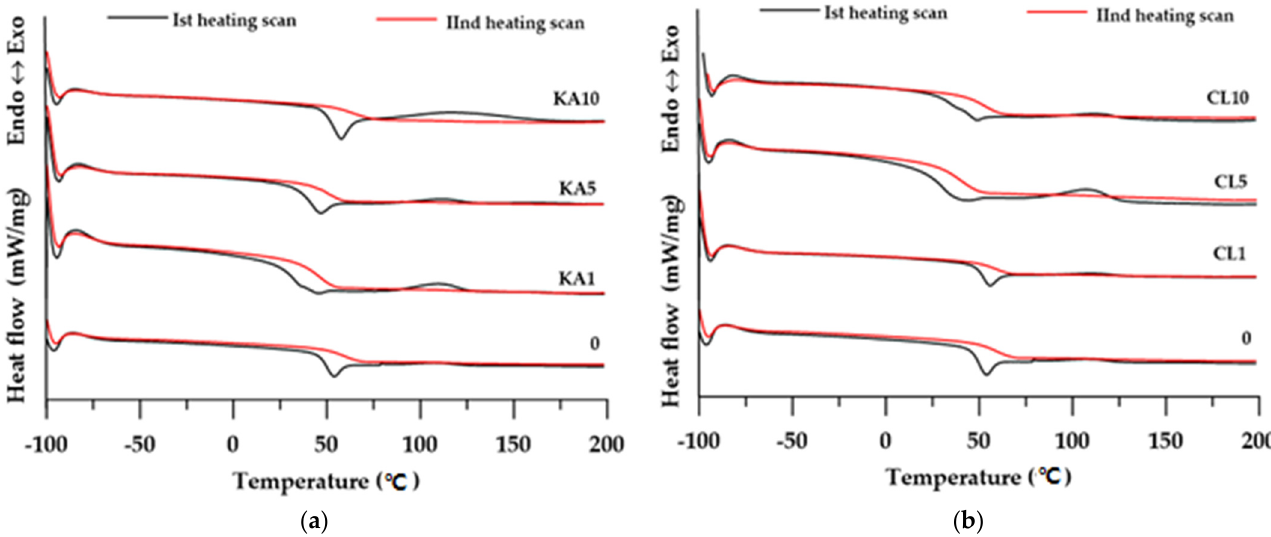
Figure 7. DSC curves of the prepared materials: ( a ) KA-based composites; ( b ) CL-based composites. The DSC curves from the second heating revealed only glass transitions (T g in the range of 40–65 ◦ C) which were higher than those determined in the first heating. This is consistent with the common knowledge that the cross-linking process shifts the glass- transition temperatures of the material towards higher temperatures.